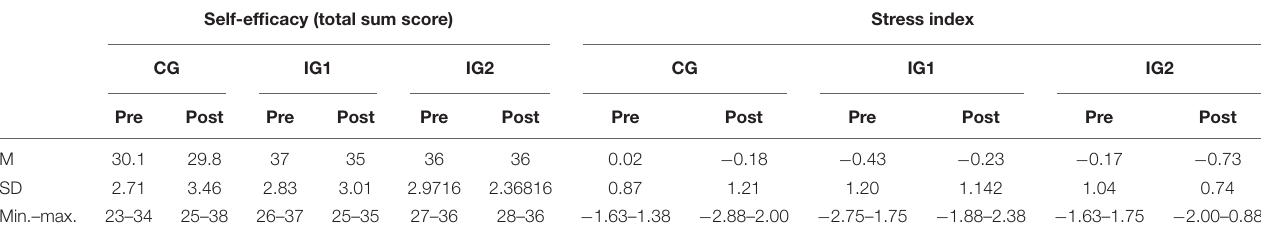
TABLE 2 | Descriptive data on self-efficacy and stress index when imagining how to teach inclusive PE for each group before (pre) and after (post) intervention. Self-efficacy (total sum score)